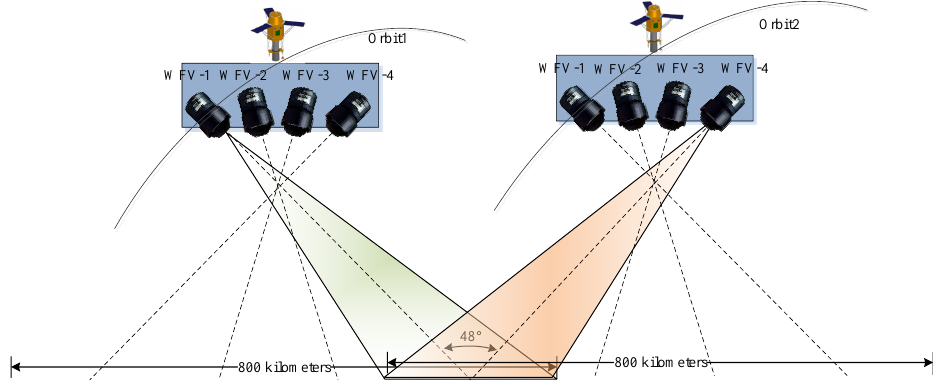
Figure 3 . Forward intersection method of the stereo partners. Partners are made up of the GF-1 WFV-1 and WFV-4 images from different orbits with common coverage. The angle between the center sights of WFV-1 and WFV-4 is up to 48°.